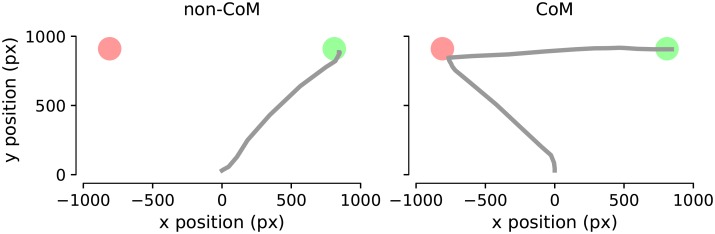
Response trajectories from two representative trials.Participants reached one of the two choice targets (red/green areas) directly in non-change-of-mind trials (left), or after reaching towards the opposite target first in change-of-mind trials (right).